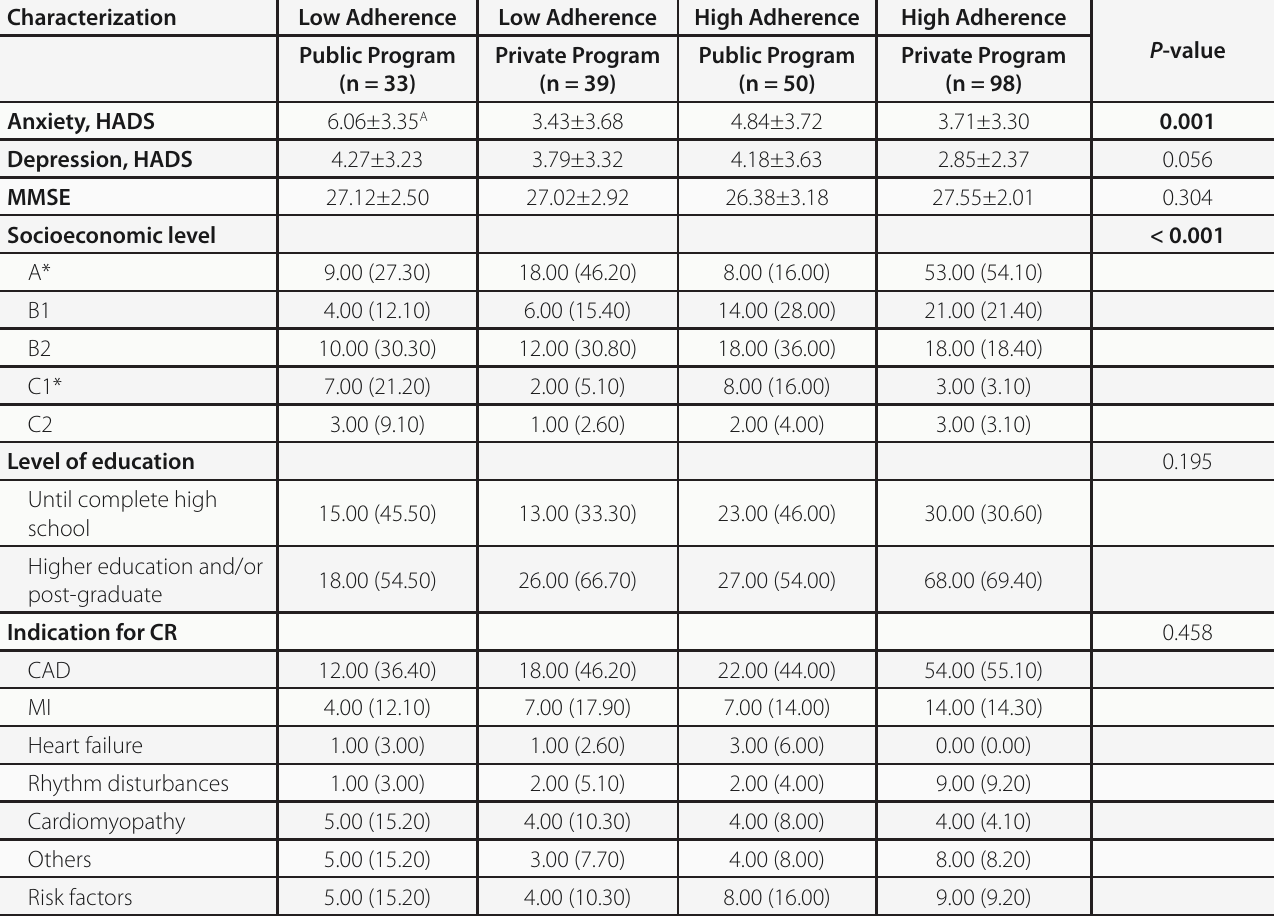
Table 2. Characterization of patients concerning levels of anxiety and depression, mental status, socioeconomic level, level of education, and indication for CR according to the type of program and